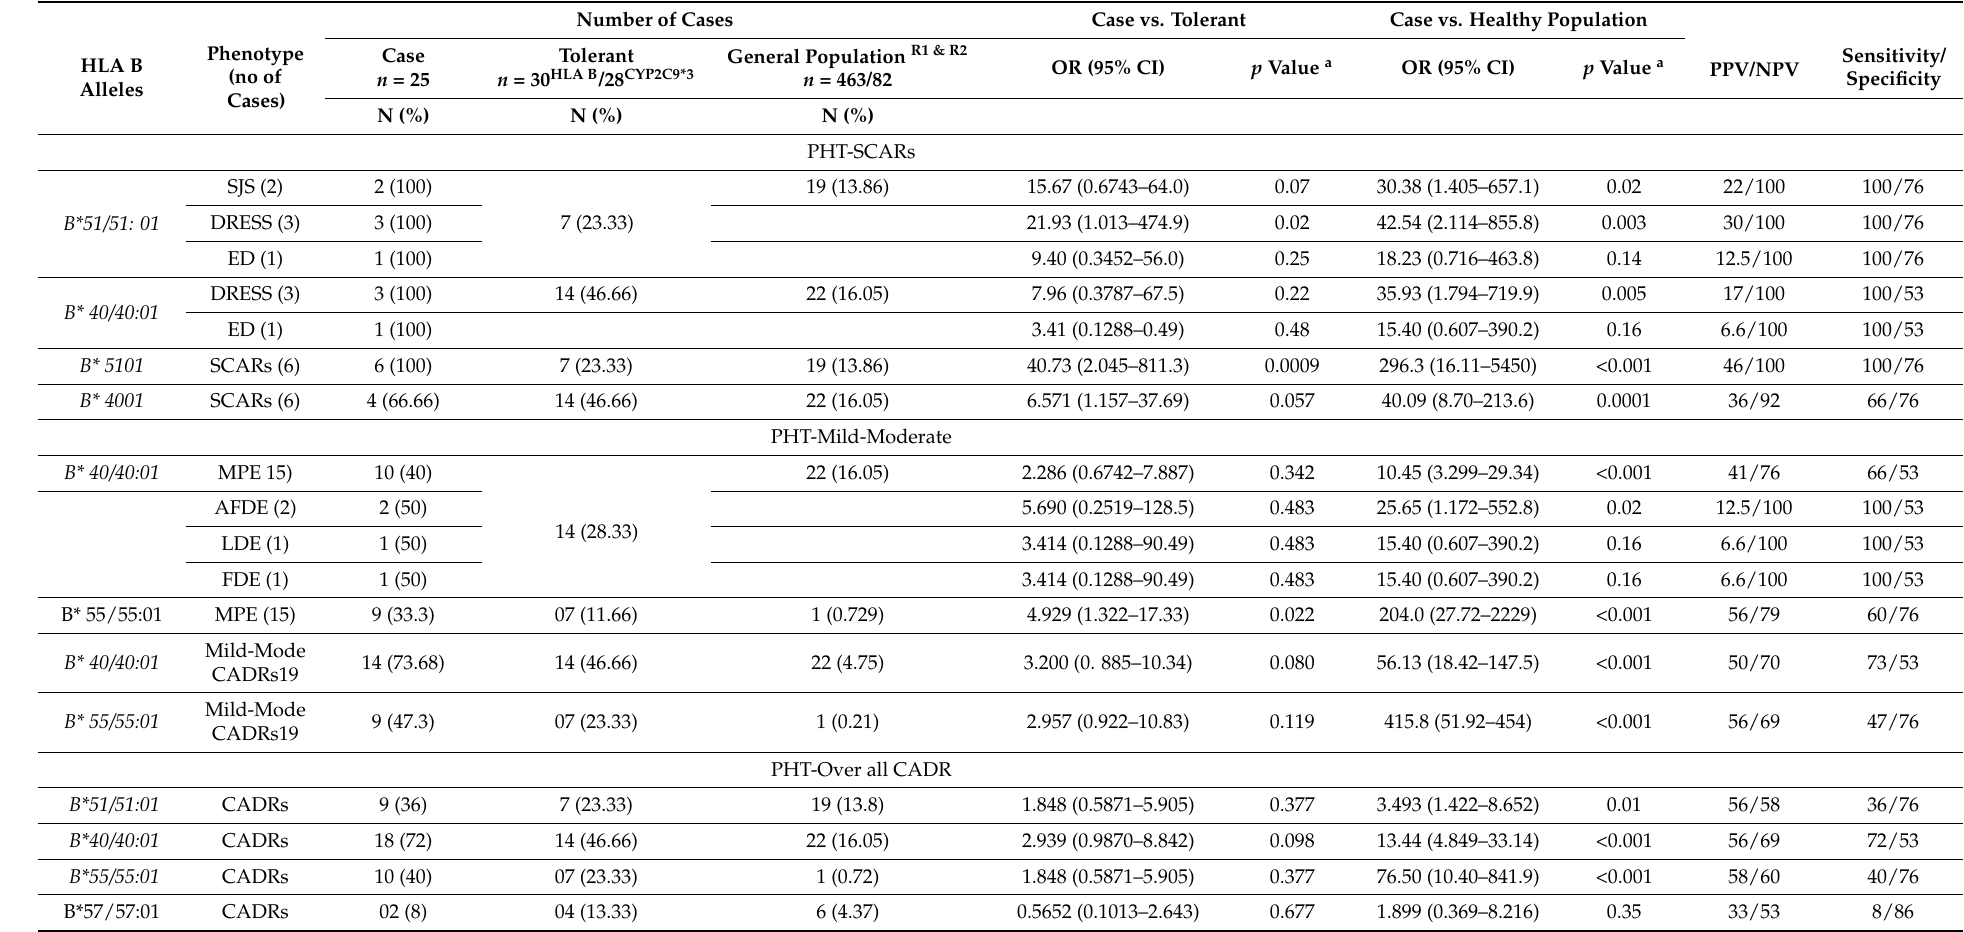
Table 2. Bivariate analyses of association between HLA B alleles and CYP2C9*3 with